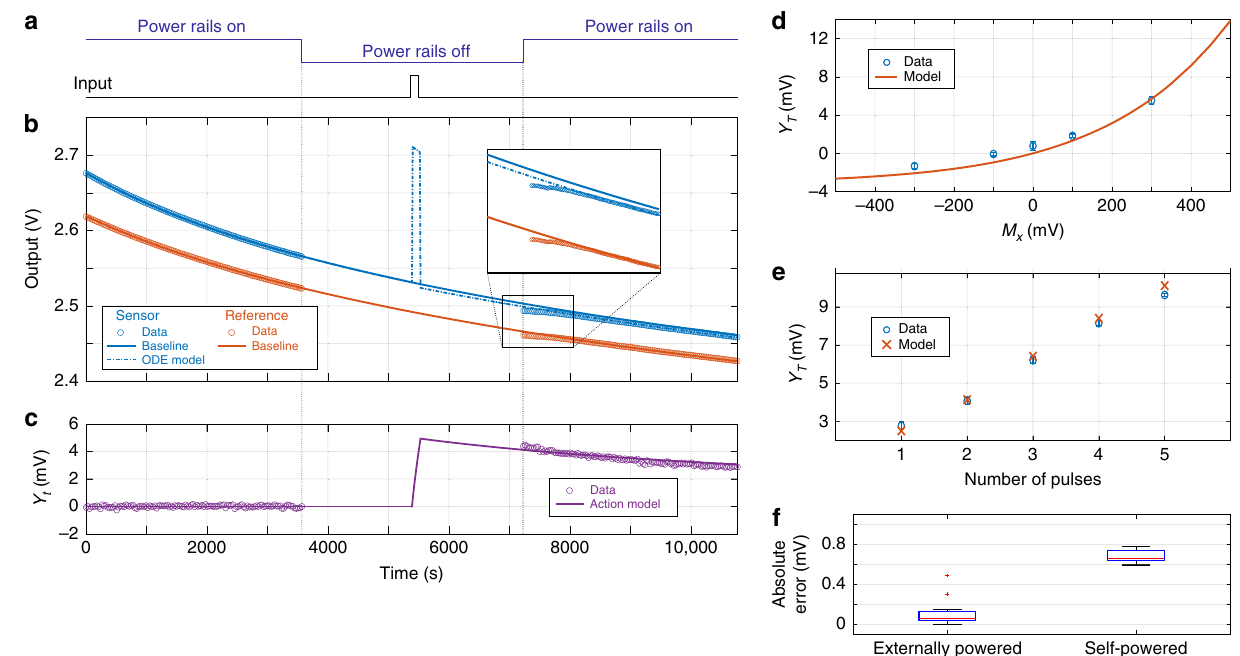
Fig. 4 Veri fi cation of the proposed device for self-powered sensing and data logging. a Power to the system is switched off at the 1-h mark, and then turned back on at 2-h mark. The input pulse is applied at the 1.5-h mark for a duration of 120 s. b , c Output measured from the recorder when the power is ON and the comparison with the predicted model showing the process of desynchronization. d Recorder responses for input signals over a range of amplitudes. Responses follow an exponential model, which can be modeled by the action model. e Recorder responses for varying number of pulses (400 mV magnitude, 50 s duration each). f Distribution of absolute errors between measured data and model predictions, for externally powered and self- powered cases estimated across all